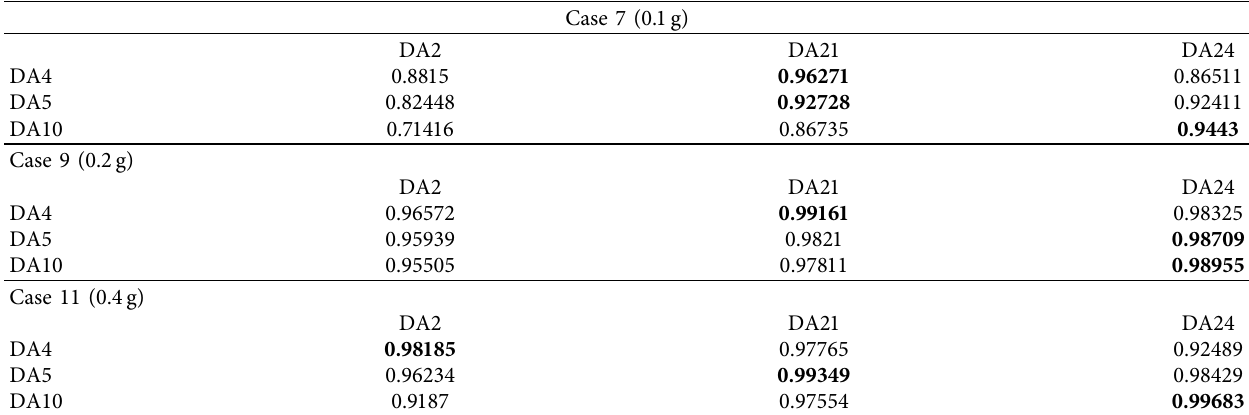
Table 5: Correlation coefficient of measuring points of pier column at mountainside and riverside under different working conditions.